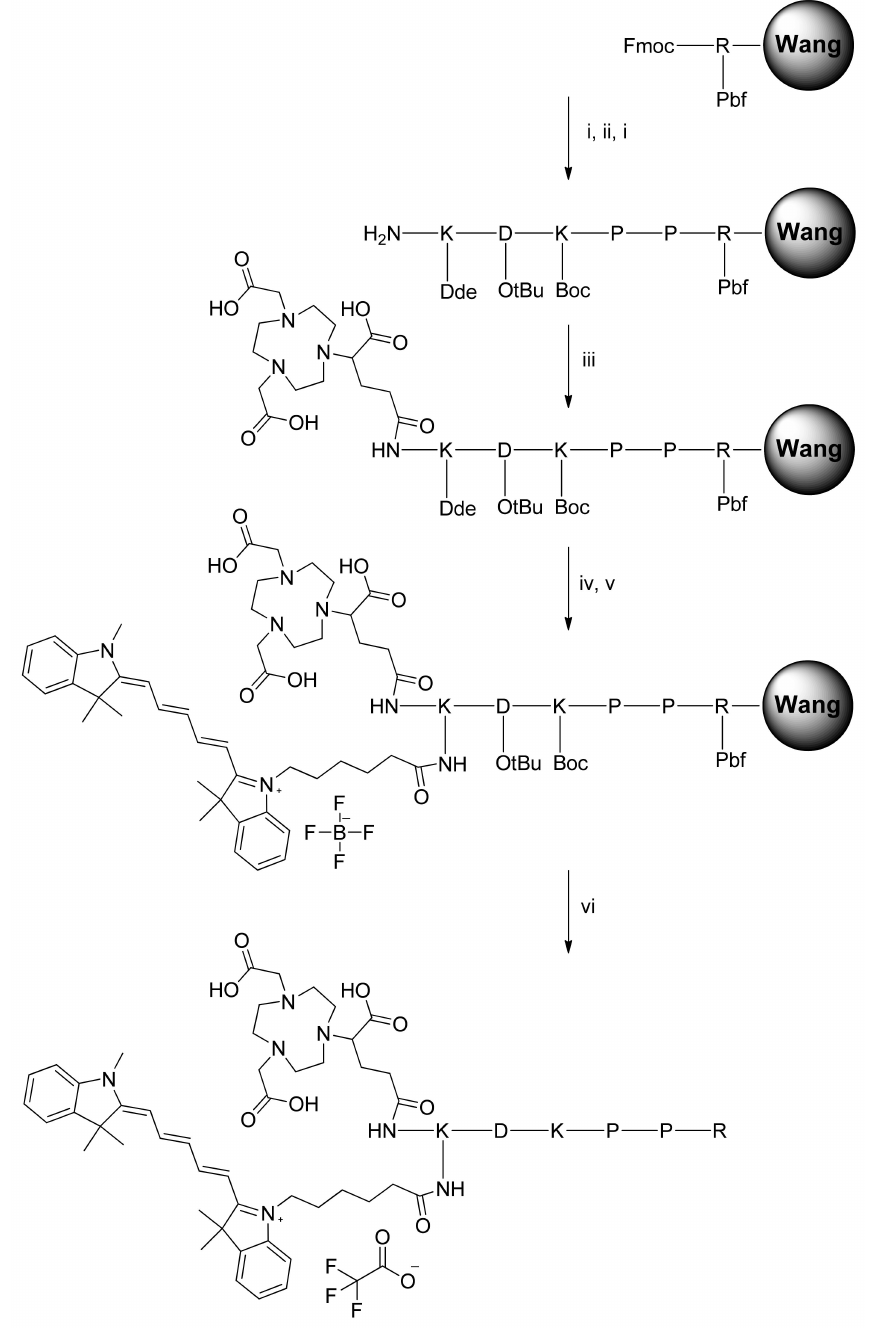
Figure 1. Synthesis of NODAGA-K(Cy5)DKPPR. Automatic and manual peptide synthesis: (i)